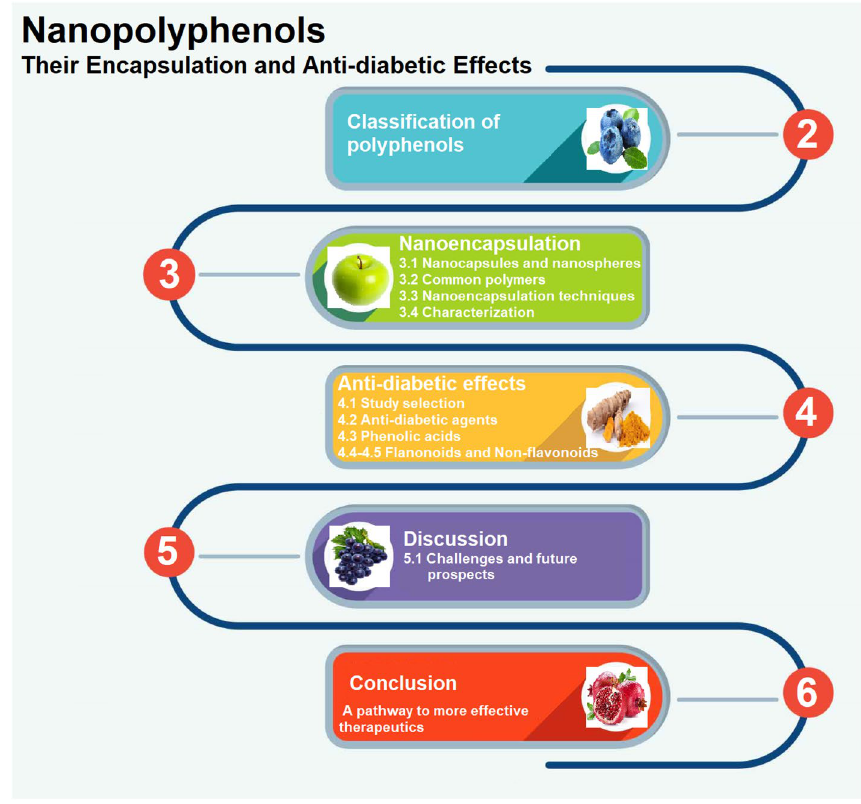
Fig. 1 Schematic representa- tion of the topics covered in the